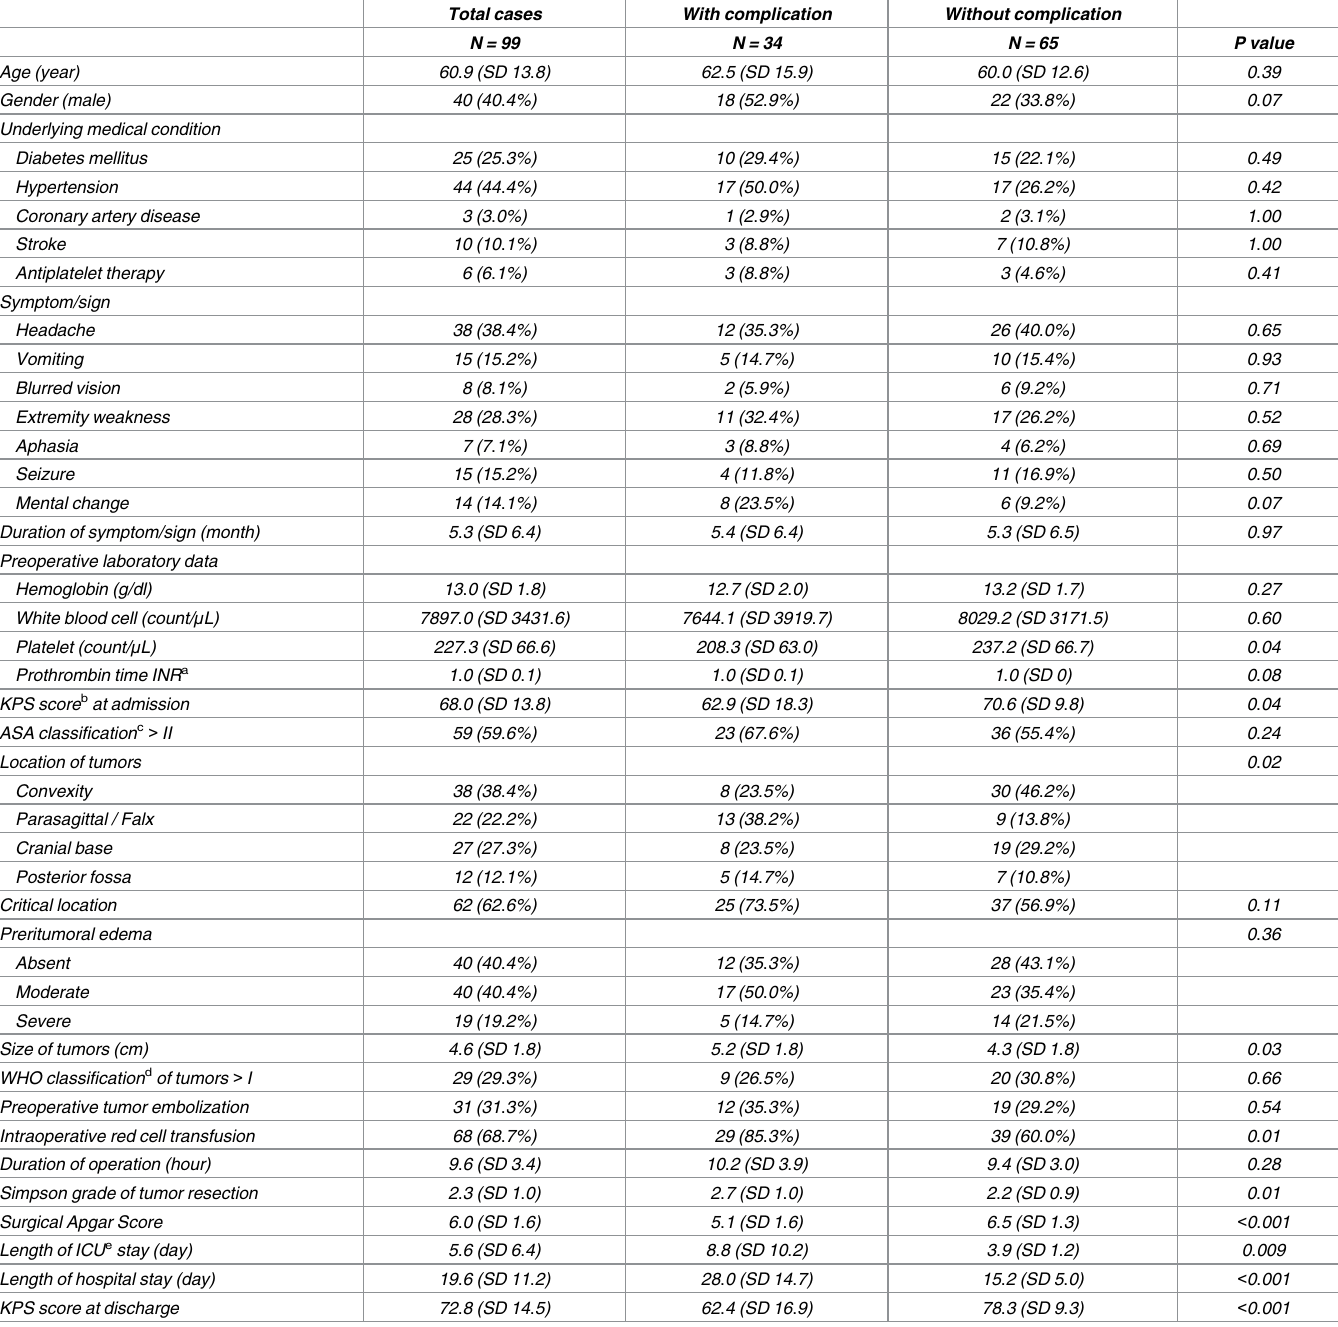
Table 3. Comparisons of clinical characteristics in patients with or without major complications after intracranial meningioma